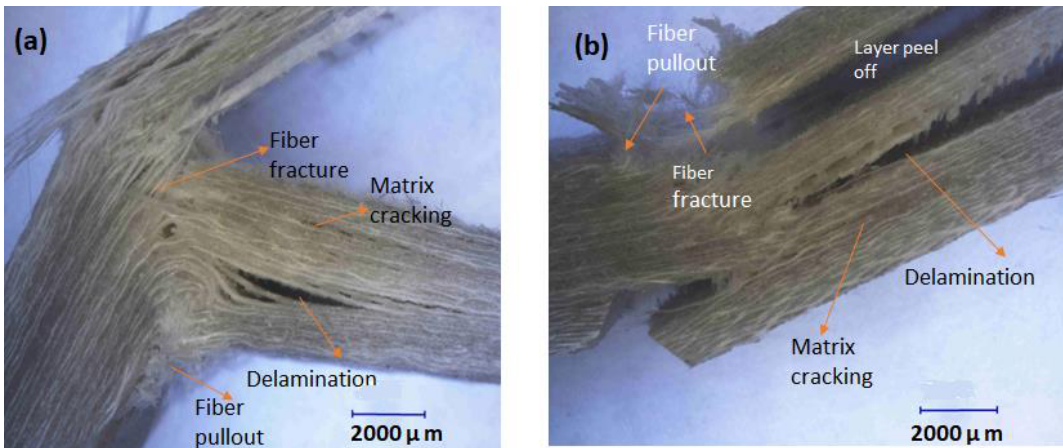
Figure 13. Set A: ( a ) cross-sectional micrograph of SMA/GFRP composite after impact; ( b ) top view of SMA/GFRP composite after impact.